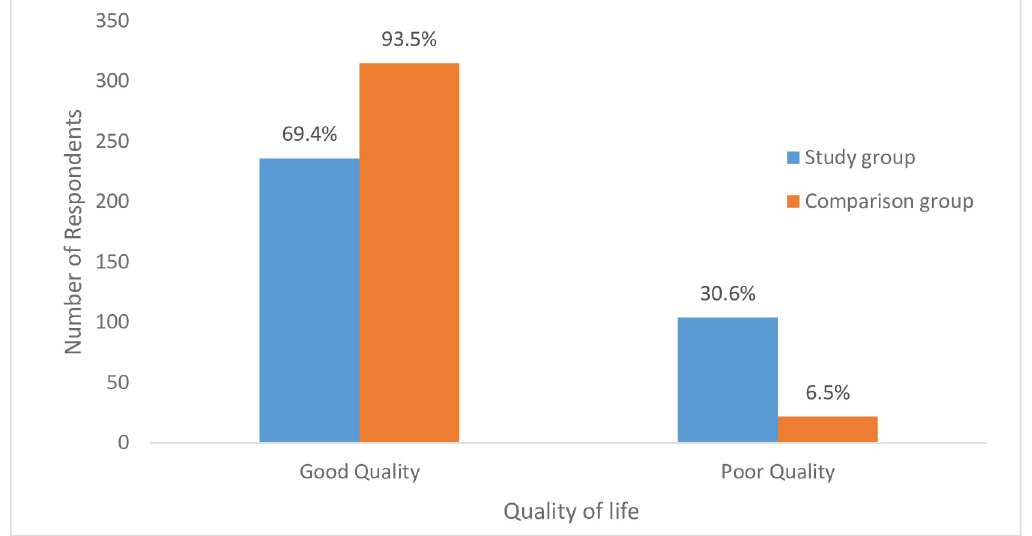
Fig 1. Comparing overall Health-Related Quality of Life measures among respondents with onchocerciasis and the control group.